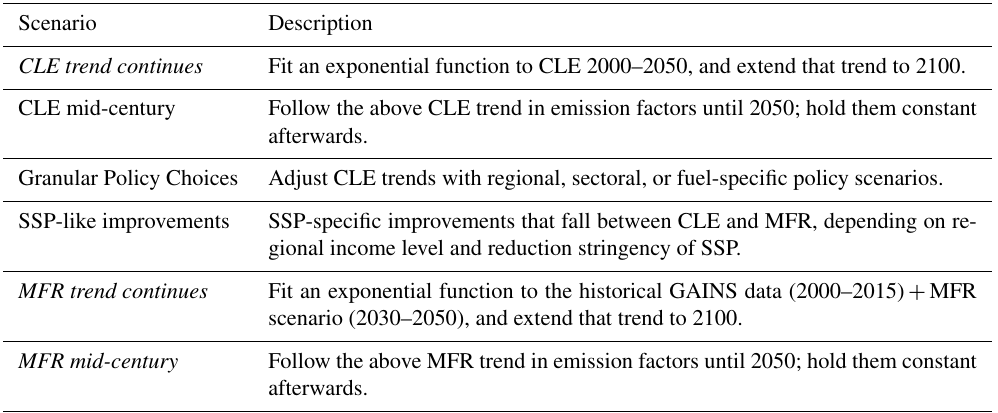
Table 3. Example emissions intensity trends, based on GAINS scenarios of current legislation (CLE) and maximum feasible reduction (MFR). Results from italicized scenarios are shown in Figs.